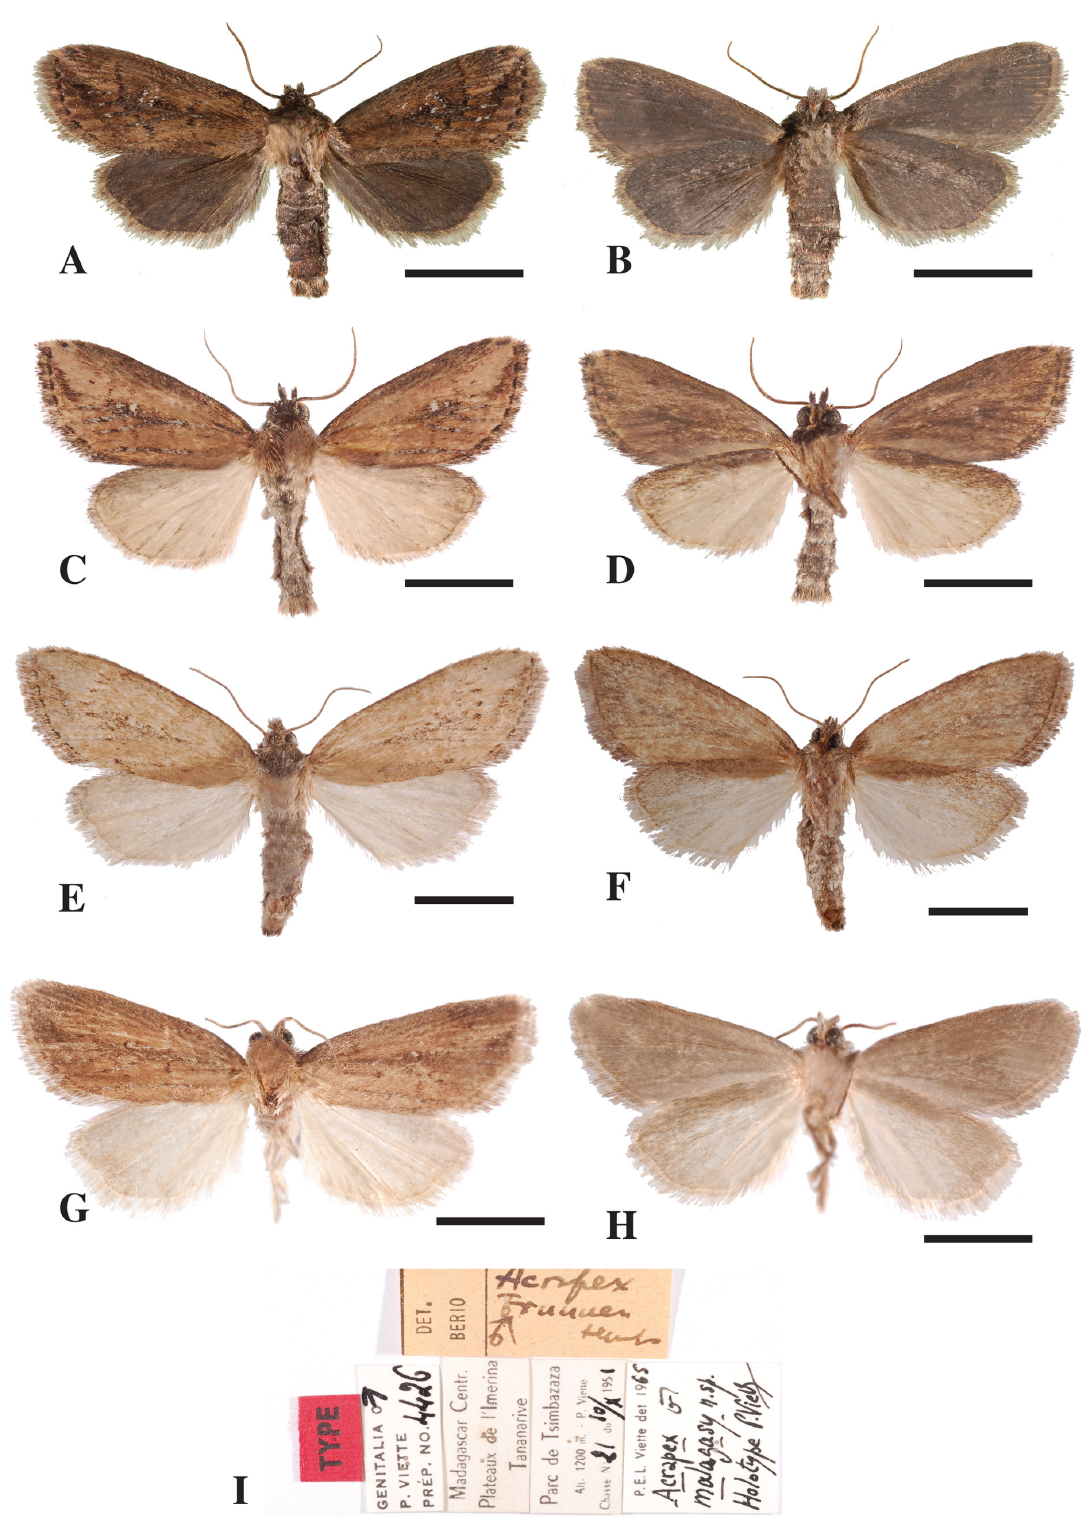
Fig. 6. Adults of species of Acrapex . – A–B . A. kavumba le Ru sp. nov. A . ♂, upper side. B . ♂, under side. – C–F . A. kiakouama le Ru sp. nov. C . ♂, upper side. D . ♂, under side. E . ♀, upper side. F . ♀, under side. – G–I . A. malagasy Viette, 1967. G . ♂, upper side. H . ♂, under side. I . ♂, original labels from MNHH. Scale bars = 10